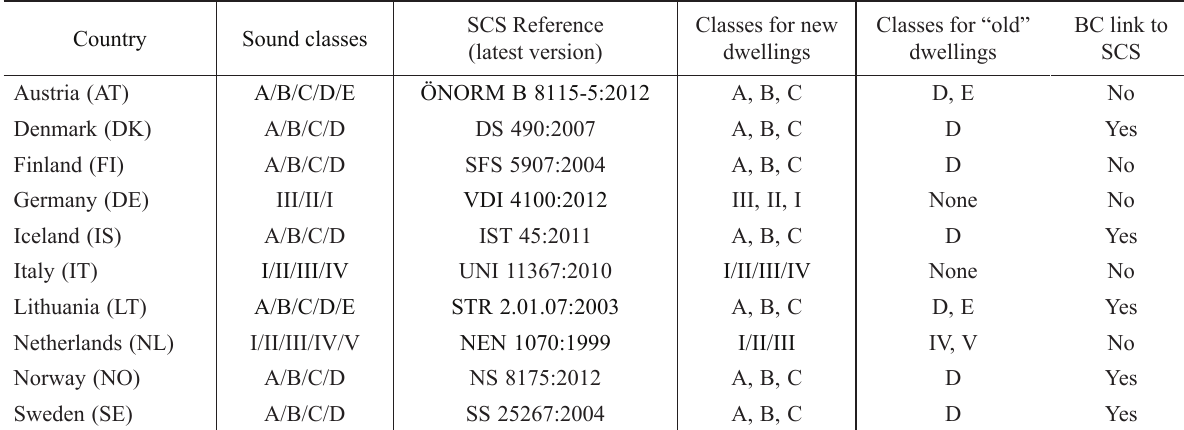
Table 1. Implementation of sound classification schemes’ in European countries (modified from Rasmussen, Machimbarena 2014b; Rasmussen 2014. Data from July 2014) Country